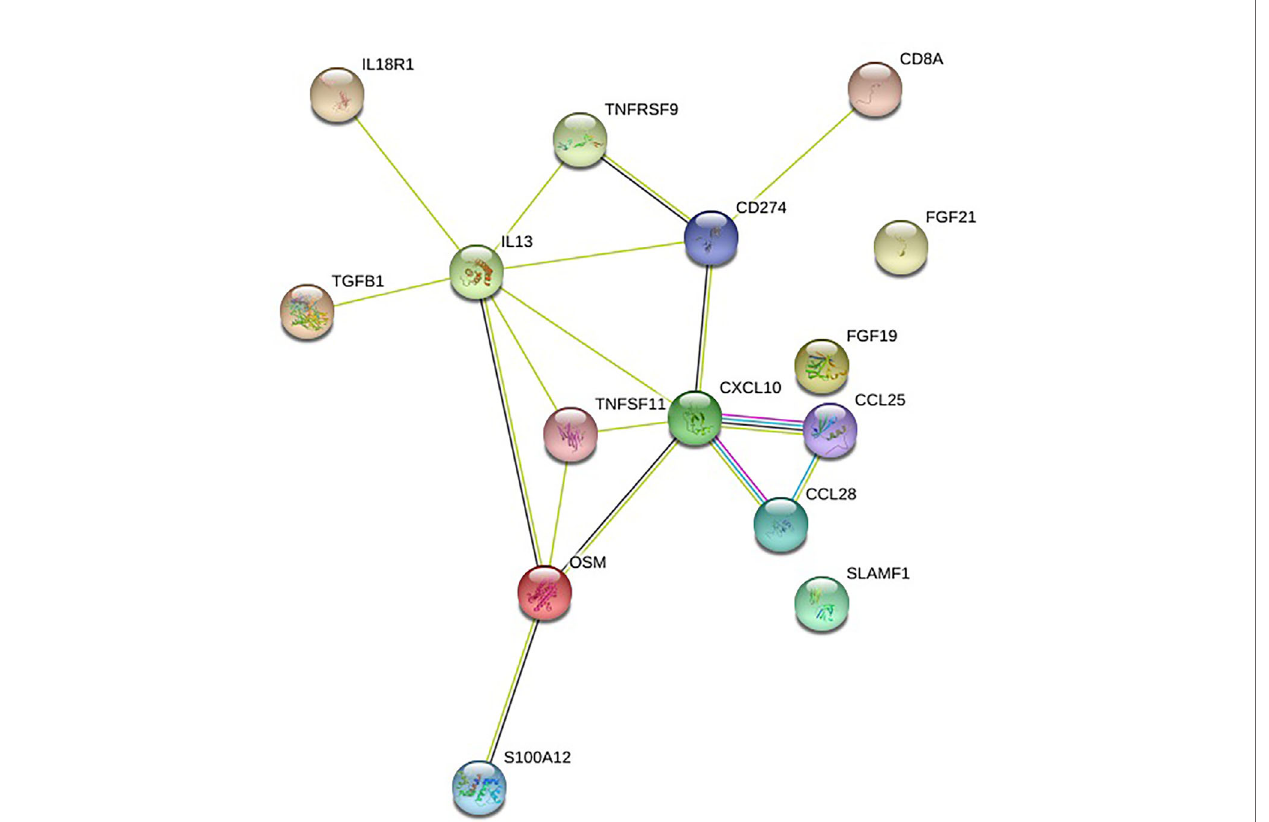
FIGURE 3 | Network of immune markers. Source: https://string-db.org/. Legend: CD274 is PDL1, TNFSF11 is TRANCE, S100A12 is EN-RAGE. See Appendix 1 for the abbreviations. Meaning of lines: blue: from curated databases, pink: experimentally determined, green: gene neighborhood, red: gene fusions, blue: gene co- occurrence, light green: text mining, black: